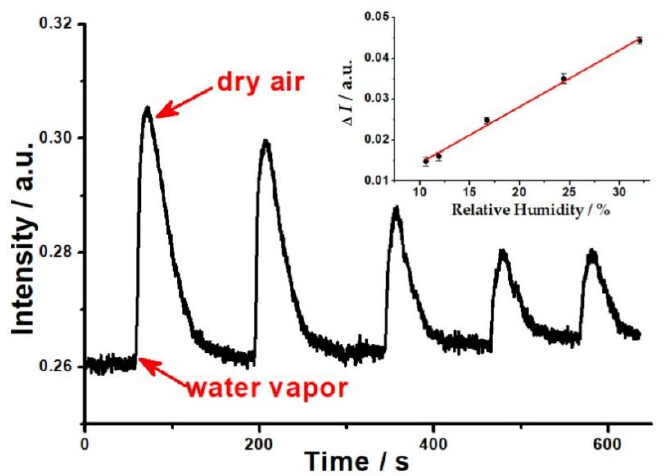
Figure 2. The response curve of mixed humid gas at different RH (the inserted graph is plot of changes in the output light intensity of the OWG sensor against samples’ RH).